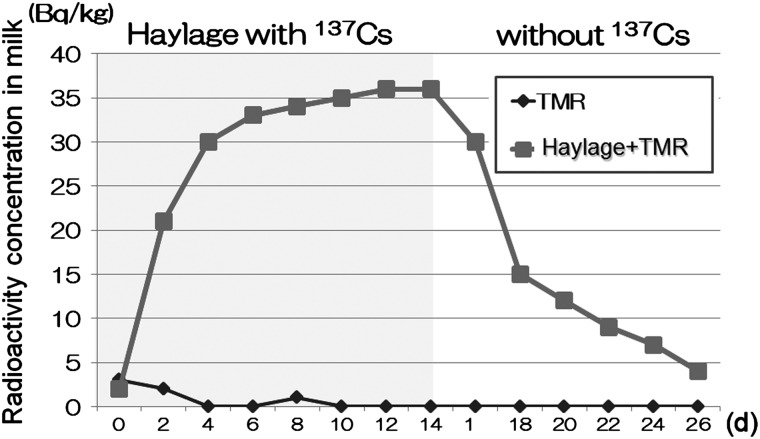
Contamination of milk [1,2]. A contaminated haylage was supplied to the dairy cattle for 14 days and the radioactivity of the milk was measured. The radioactivity of the milk was detected immediately after the supply of the contaminated haylage and reached a plateau after 14 days. Then, the supply of contaminated haylage was stopped and only non-contaminated total mixed ration (TMR) feed mixture was supplied for another 14 days The radioactivity in the milk gradually decreased and the value was close to the control value after 14 days (N. Manabe et al.).